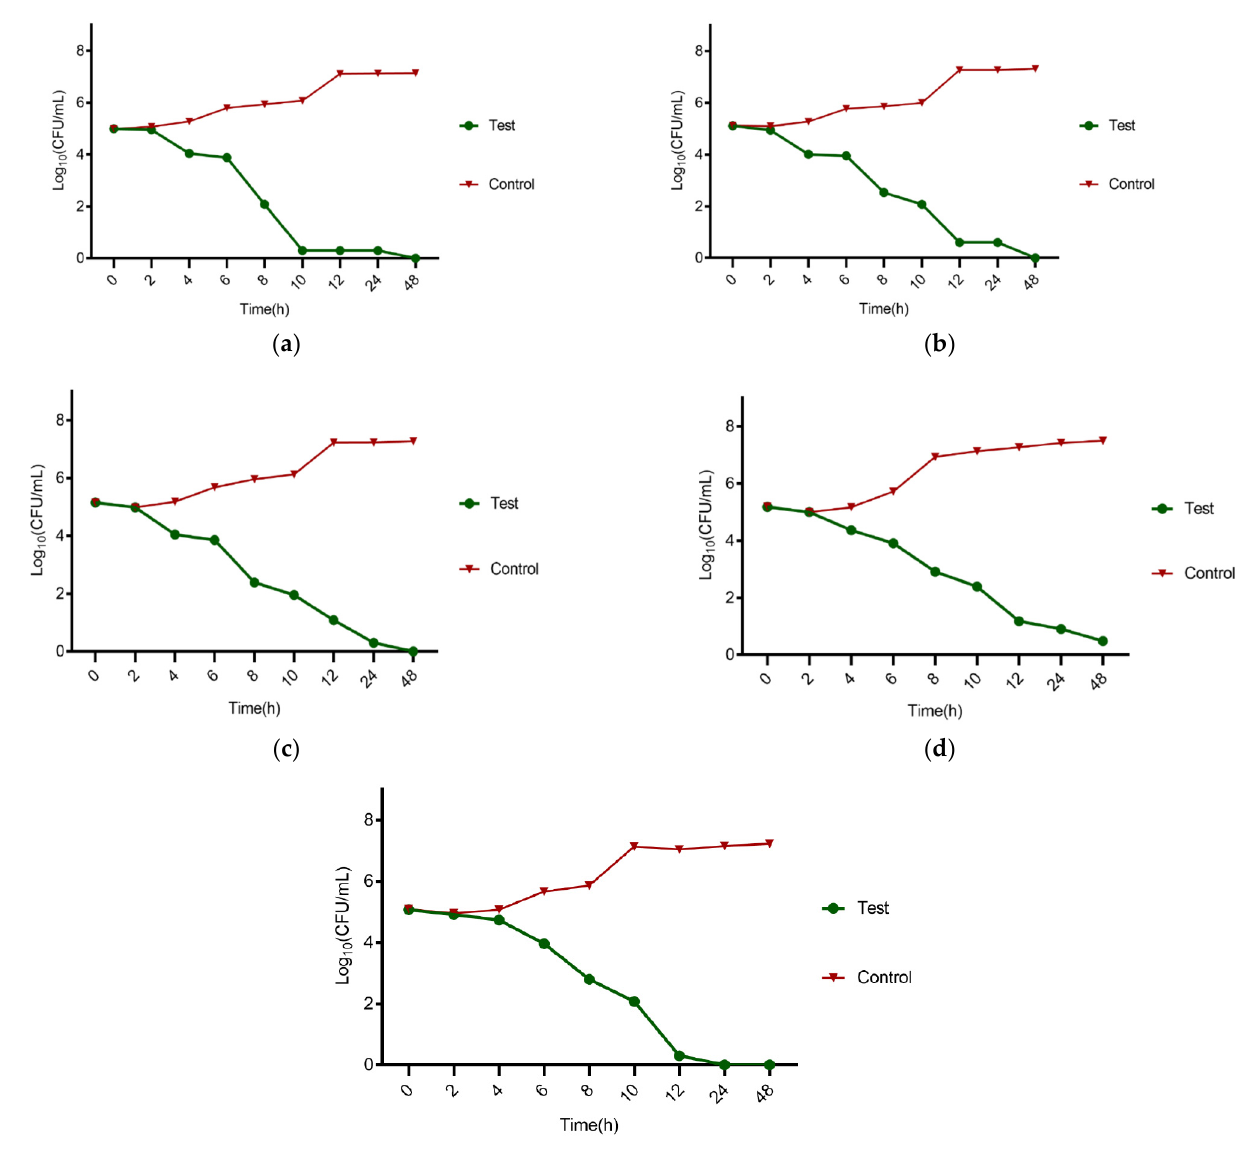
Figure 1. The results for the Time Kill Assay; ( a ) E. faecalis , ( b ) S. aureus , ( c ) S. mutans , ( d ) E. coli , and ( e ) P. gingivalis ,